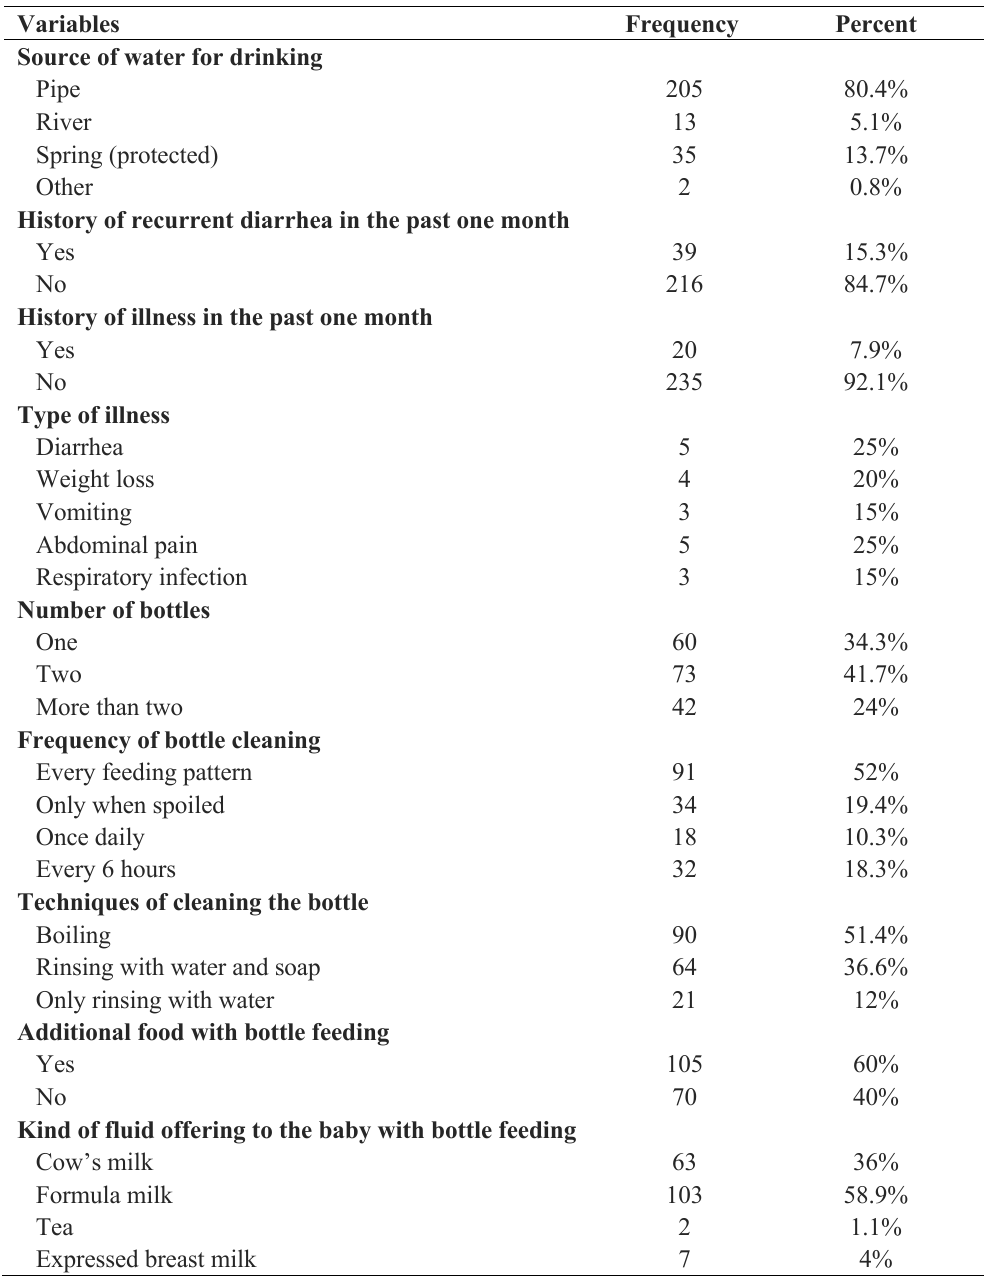
Table 4. Health status of infants less than 24 months of age in Woldia General Hospital, Ethiopia, 2019